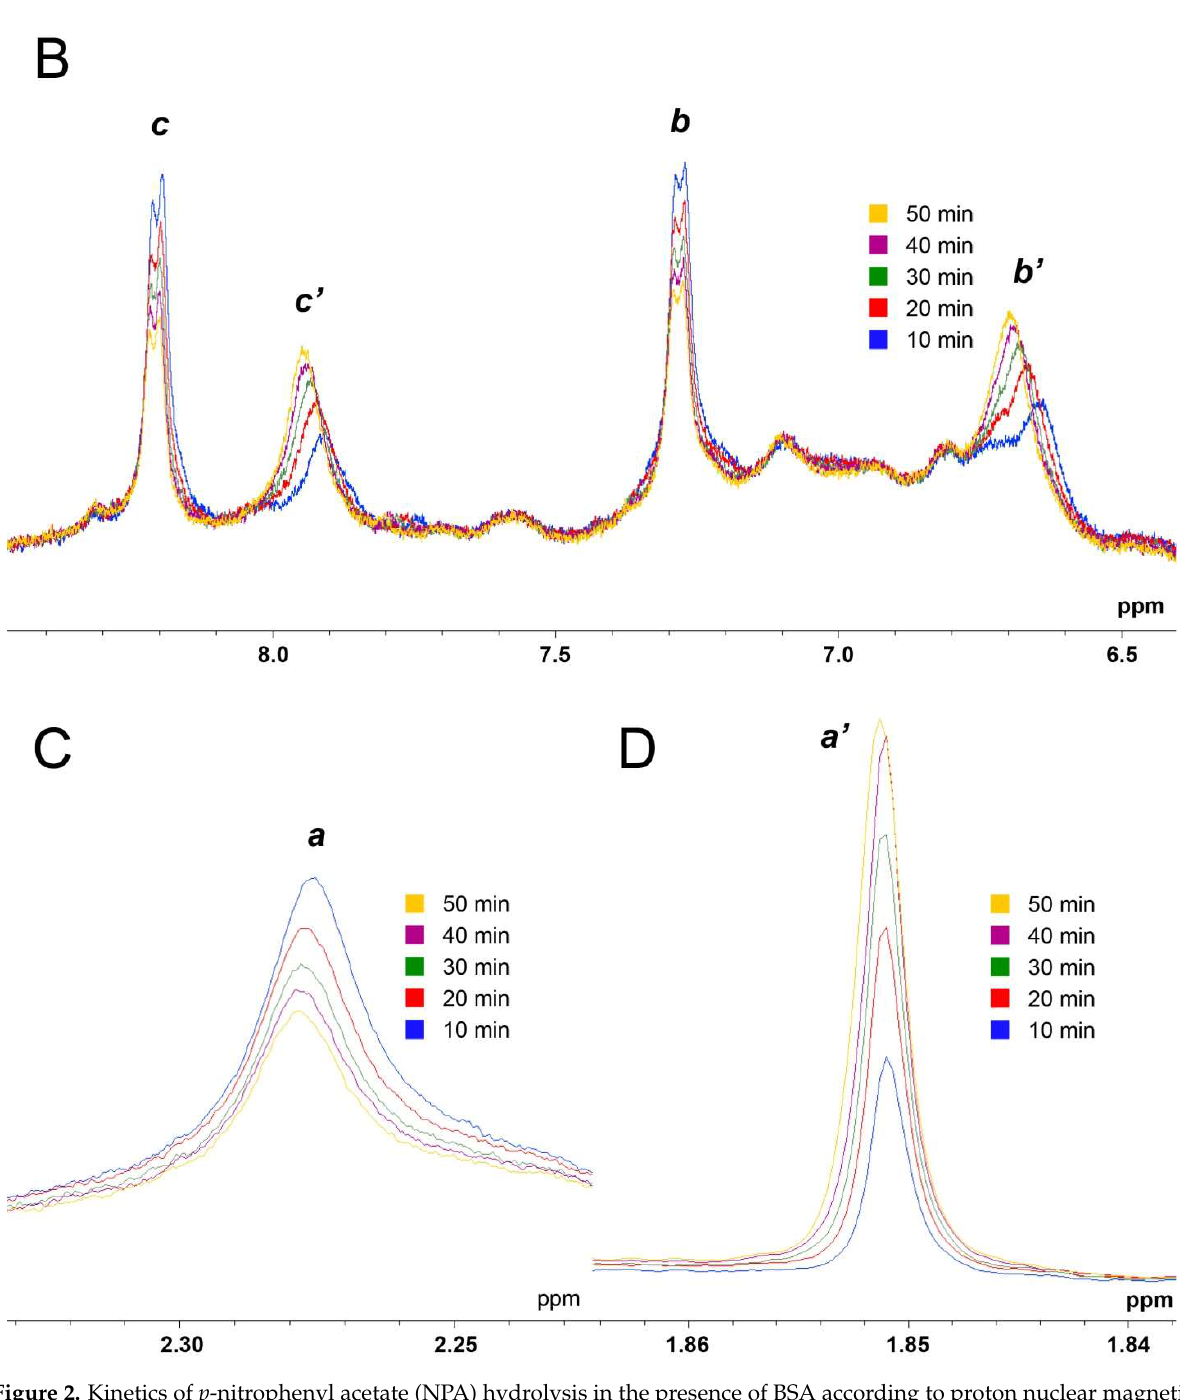
Figure 2. Kinetics of p -nitrophenyl acetate (NPA) hydrolysis in the presence of BSA according to proton nuclear magnetic resonance ( 1 H NMR). ( A ) full spectrum; ( B ) aromatic region of the spectrum; ( C ) signal of the acetic moiety of NPA; ( D ) signal of free acetate. The impurities are marked with asterisks. Internal standard sodium trimethylsilylpropanesulfonate is labelled as DSS; dimethyl sulfoxide is labelled as DMSO.